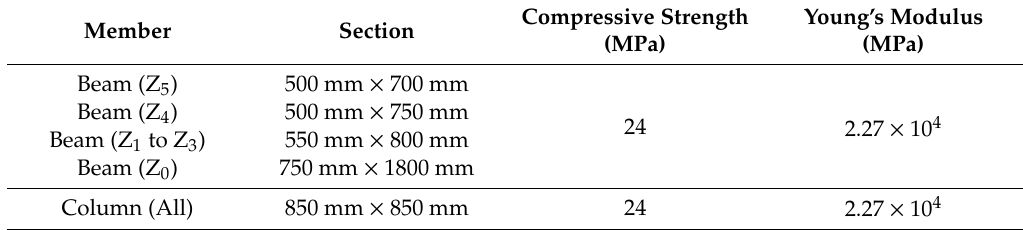
Figure 2. Simplified structural plan and elevation (Model-14): ( a ) plan of levels Z 1 to Z 14 , ( b ) plan of level Z 0 , and ( c ) elevation of frame Y 2 . Table 1. Member sections, compressive strength, and Young’s modulus of concrete for Model -05.